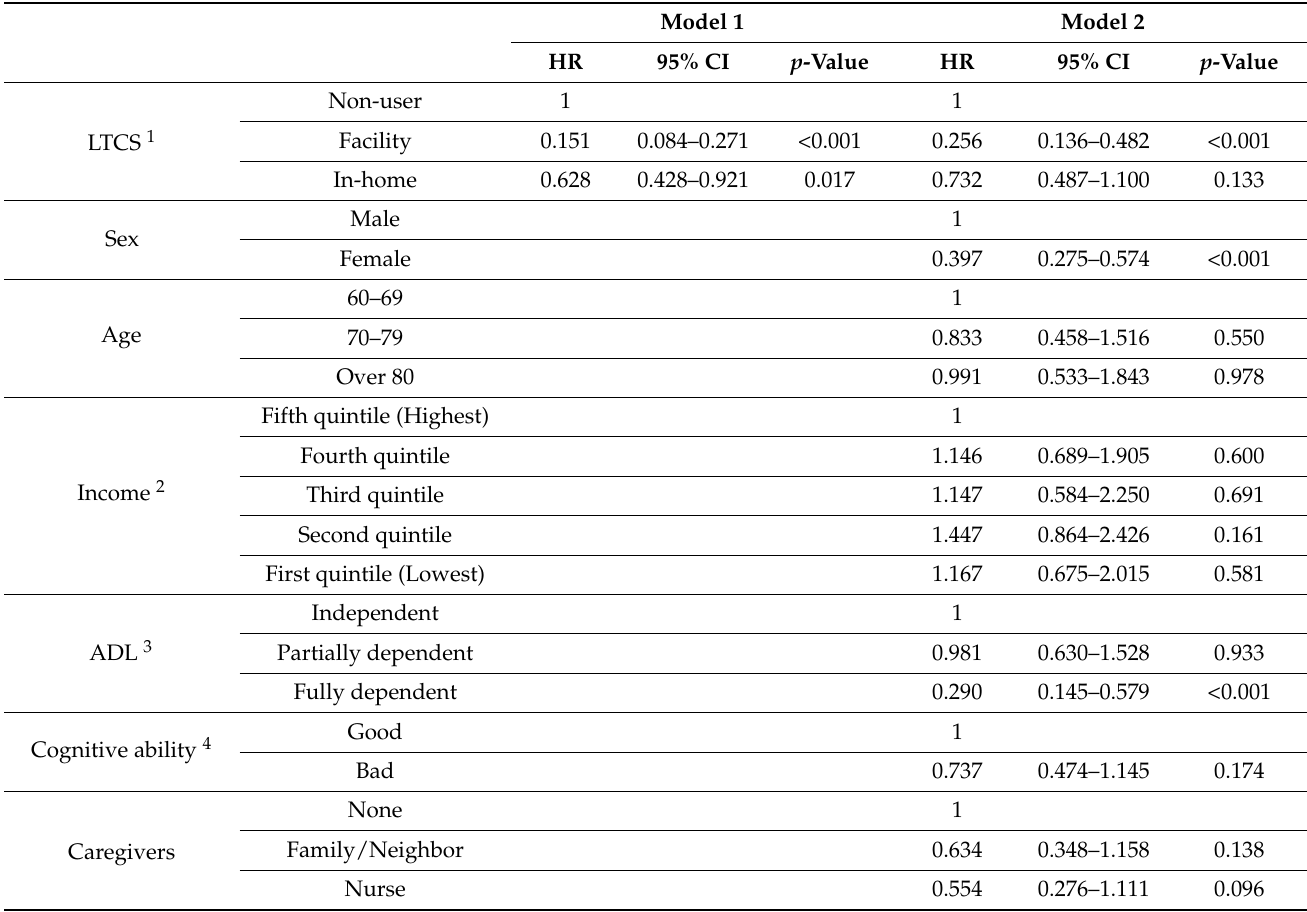
Table 2. Cox proportional hazard regression for